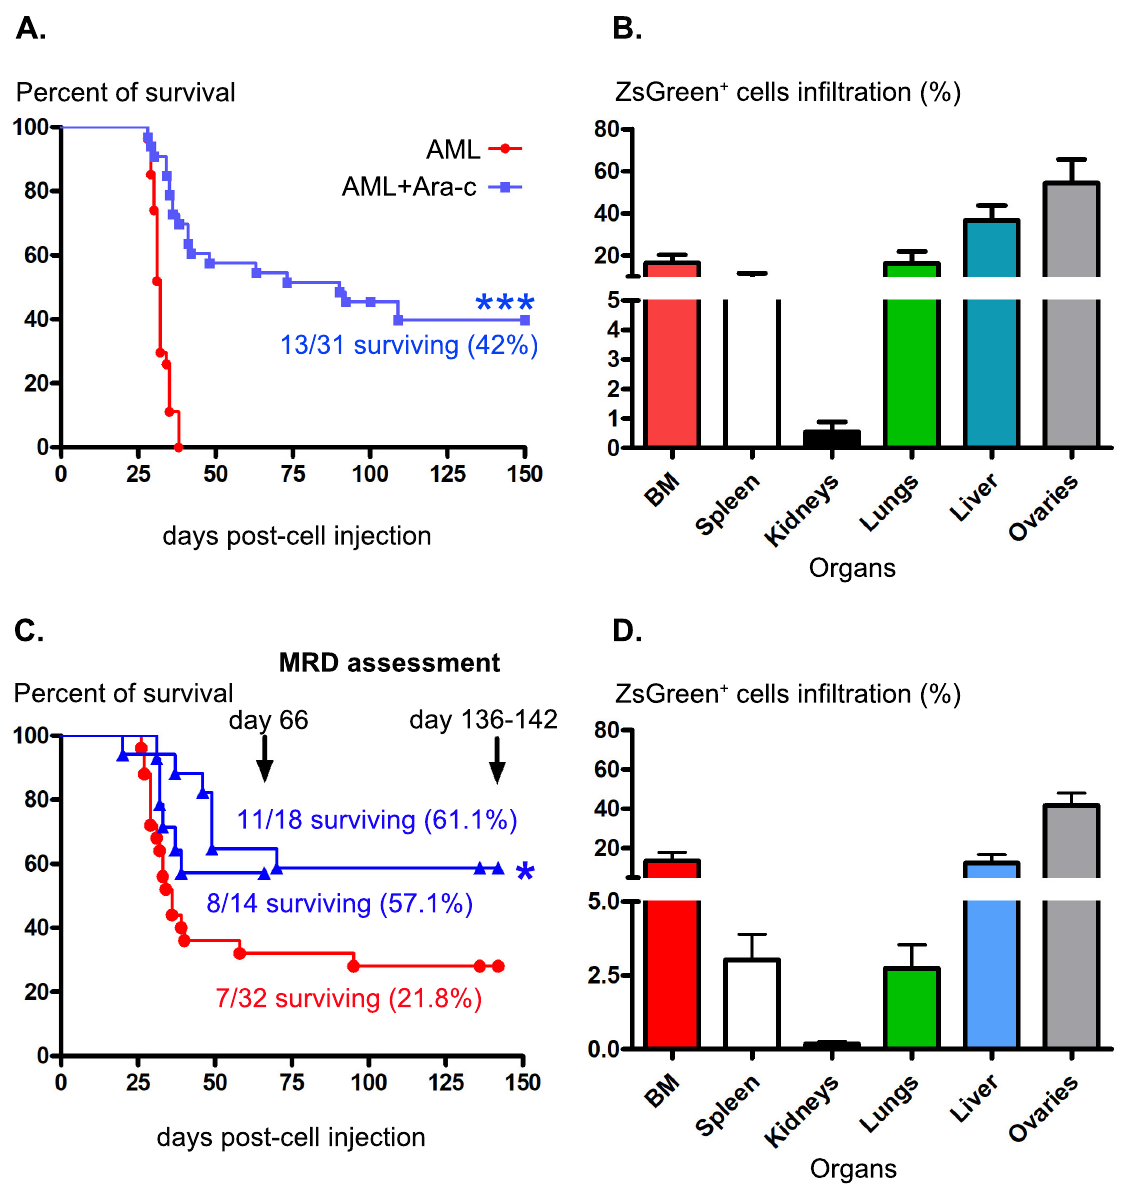
Fig 3. Ara-c treatment favors the prolonged survival of mice injected with B11/C5/E7 subclones expressing or not expressing WT1. (A) Survival curves of leukemic mice receiving (blue line) cytarabine treatment or not (red line) 10 days after joined injection of the B11, C5 and E7 subclones. (B) Percentages of ZSGREEN + cell infiltration in lymphoid and nonlymphoid organs in B11/C5/E7 AML-succumbing mice. (C) Survival curves of animals injected with B11/C5/E7/WT1-expressing subclones and treated (blue line) or not (red line) with chemotherapy. Mice were sacrificed 66 and 136–142 days after cell injection for residual AML cell assessment. (D) Percentages of ZSGREEN + cell infiltration in different organs in B11/C5/E7/WT1 AML-succumbing mice. ��� , p < 0 . 0001 , log-rank test comparing B11/C5/ E7-injected mice treated or not with Ara-c; � p = 0 . 0174 , comparison of B11/C5/E7/WT1-bearing animals with or without chemotherapy treatment using the log-rank test and GraphPad Prism (V5.0). E7AML-surviving mice presented circulating ZSGREEN + cells in the peripheral blood (Fig 3A). These cells could be tracked in each individual mouse from 80 to 106 days after subclonal injection (42 to 68 days after the AML control group succumbed) (Fig 5A). Their frequencies ranged from 0.1 to 1.33%, and 2 mice presenting higher percentages (10.48% and 4.33%, 100